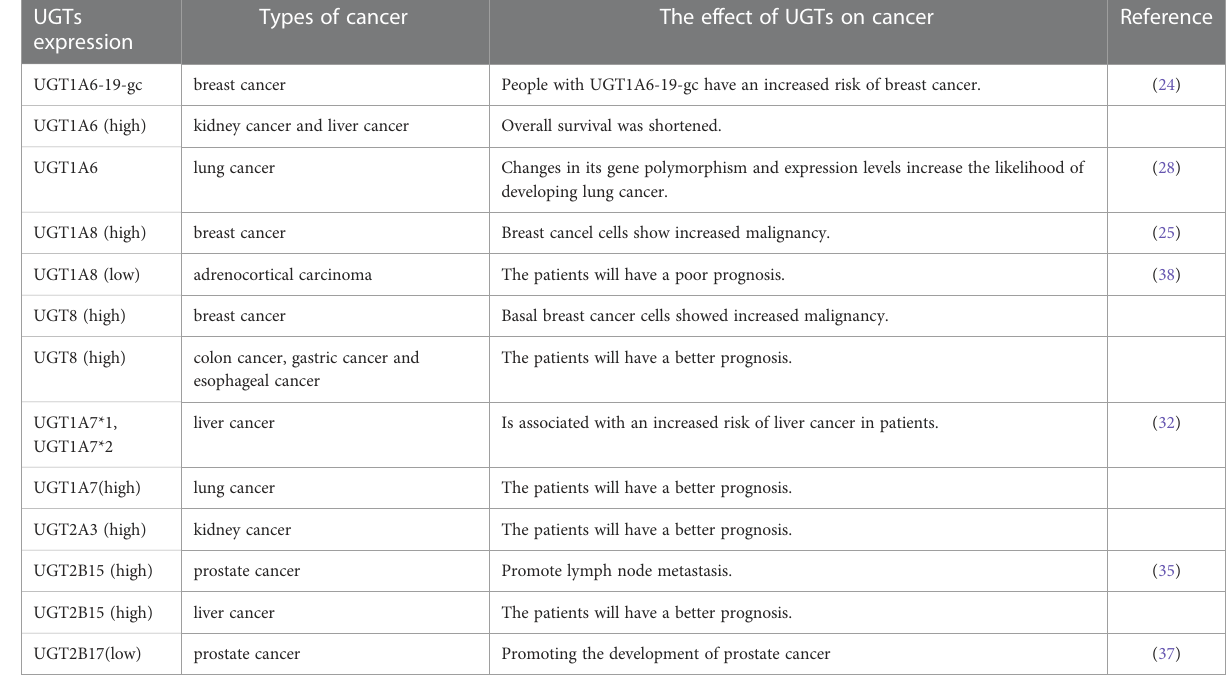
TABLE 1 Relationship between UGTs expression and cancer. UGTs Types of cancer The effect of UGTs on cancer expression